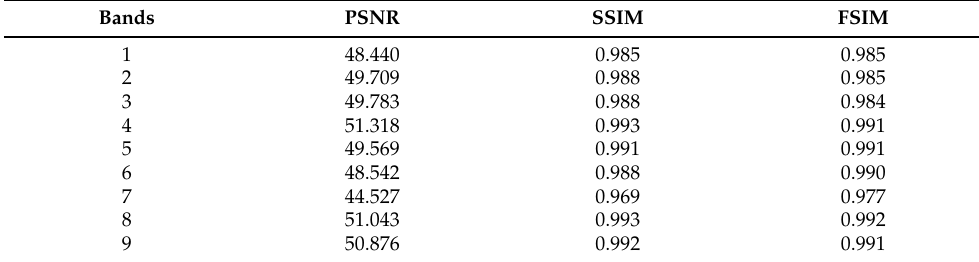
Table 2. Compression Ratio (20.7):1 over 400 epochs PReLU activation function for the Lombardia Sentinel-2 dataset.